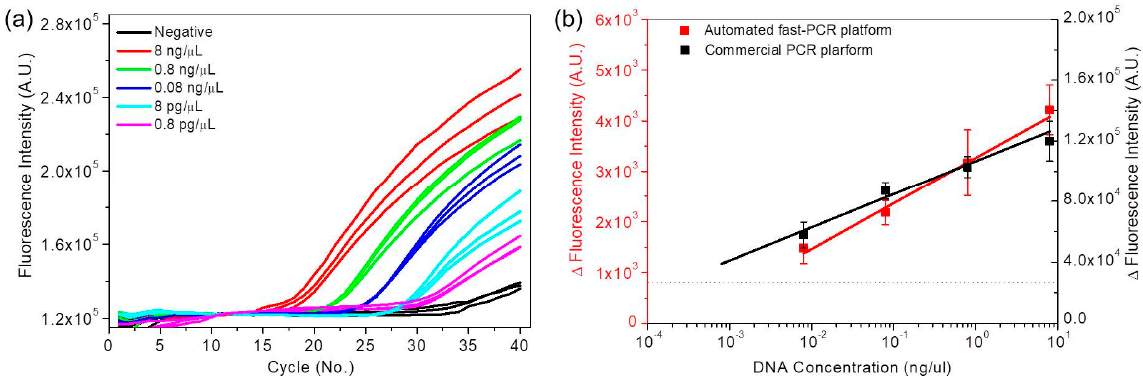
Figure 6. ( a ) Real-time fluorescence curves of 10-fold serial dilution samples (10 − 1 to 10 − 5 , 8 to 0.0008 ng/ μ L) from the commercial PCR device. ( b ) Variations in fluorescence intensity at 40 cycles from the automated fast PCR system and commercial PCR device.